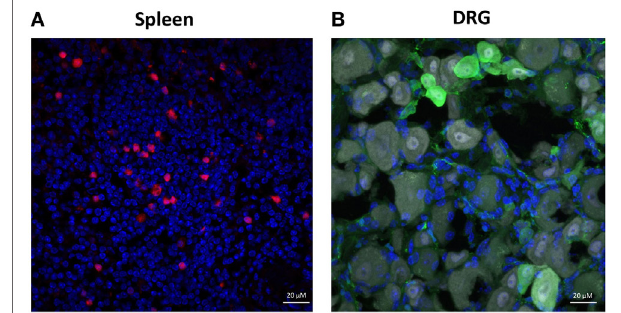
FigUre 4 | Mouse dorsal root ganglion (DRG) neurons lack Ig γ 1 chain expression. Immunohistochemical staining of spleen and whole DRGs isolated from alum + KLH-immunized mice expressing tdTomato under the control of the Ighg1 promoter. (a) Spleens express Ig γ 1 chain (red) (DAPI = blue). (B) DRG neurons express NeuN (gray) and IgG (green), but not Ig γ 1 chain (red; tdTomato) (DAPI = blue). 400 × magnification; scale bar = 20